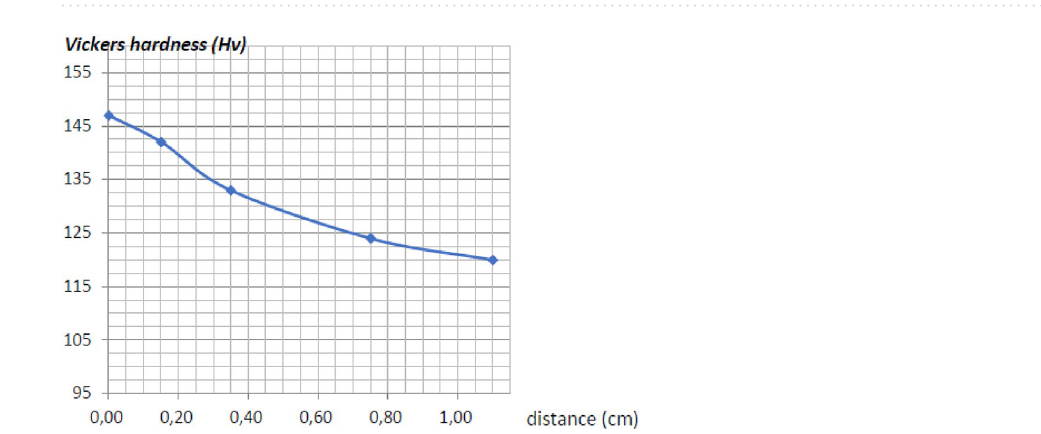
Figure 4. Microstructure of the welded steel 316L [magnified 300 times]. ( a – c ) from MZ, HAZ and BM zones; respectively.